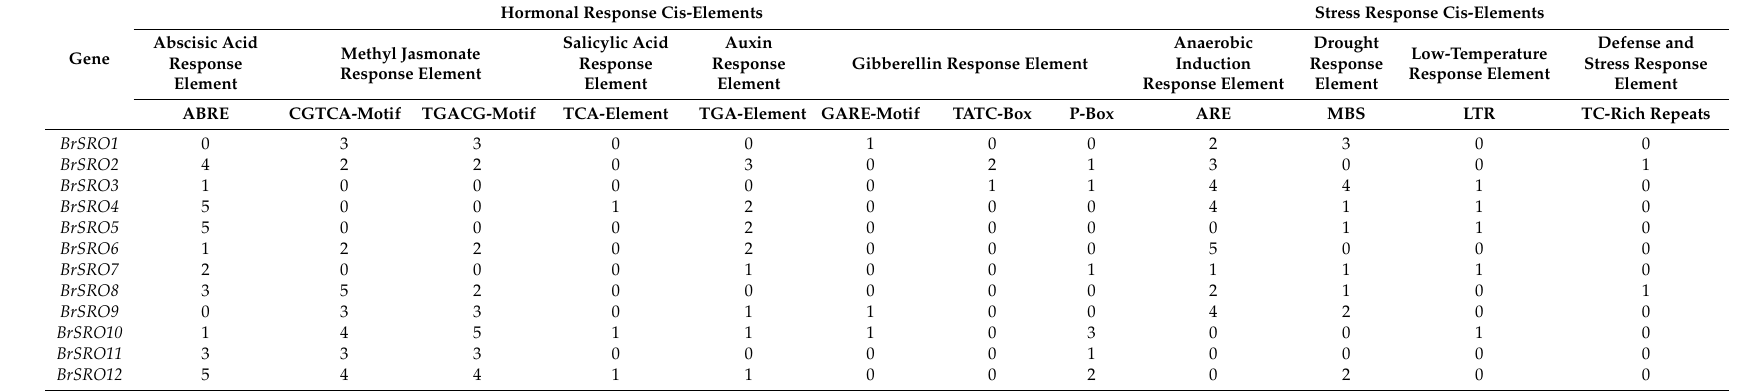
Table 2. Putative cis-elements existed in the 2 kb upstream region of BrSRO gene